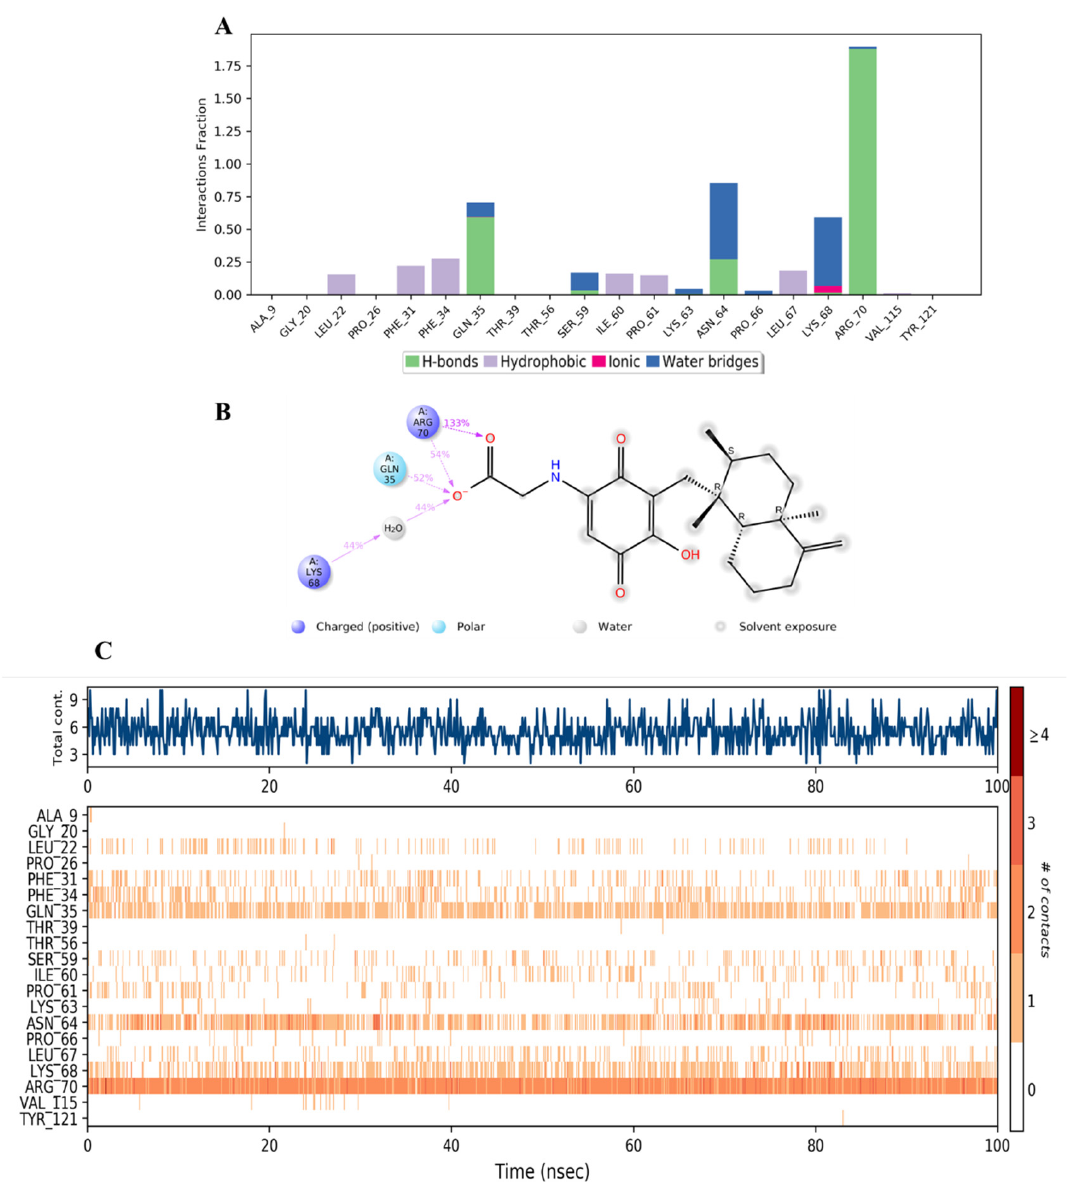
Figure 17. ( A ) Stacked bar graph of hDHFR (PDB: 1KMV) interactions with compound 28 throughout the simulation. The values were normalized over the course of the trajectory. ( B ) A diagram illustrating the detailed connections of 28 with hDHFR. The coordination that appears at least 30% of the designated time period (0.00 to 100.00 nsec) will be presented. It is possible to observe more than 100% as some residues might be linked to the same ligand atom more than once; the pink colored arrows represent the hydrogen bond interaction while the % on the arrows represent the coordination % during the simulation time. ( C ) Timeline of hDRFR- 28 interactions presented in ( A ). The top panel presents the total number of specific interactions the protein made with the ligand over the course of the trajectory. The bottom panel presents the residues interacting with the ligand in each trajectory frame. The dark orange color indicates more than one specific interaction is made between some residues and the ligand. As the orange color becomes lighter, the number of contacts between the residue and ligand decreases. The white color indicates no interaction is formed.